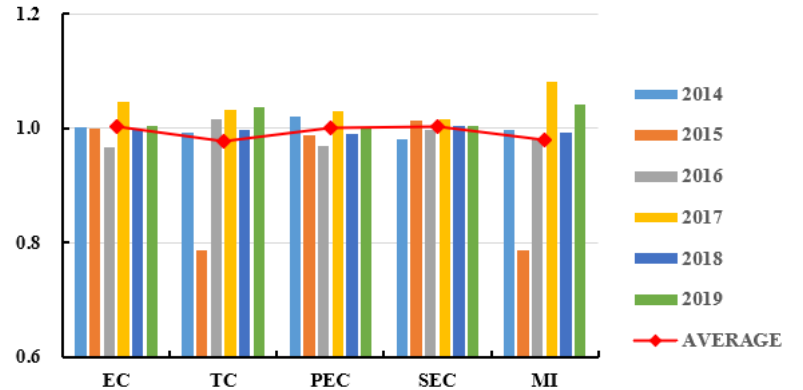
Figure 5. Total factor productivity index and the decomposition of WRM in China. Note: EC = Comprehensive technical efficiency changes; TC = Technical progress changes; PEC = Pure tech- nical efficiency changes; SEC = Scale efficiency changes; MI = Total factor productivity; AVERAGE = the 7 year average WRM performance and the decomposition